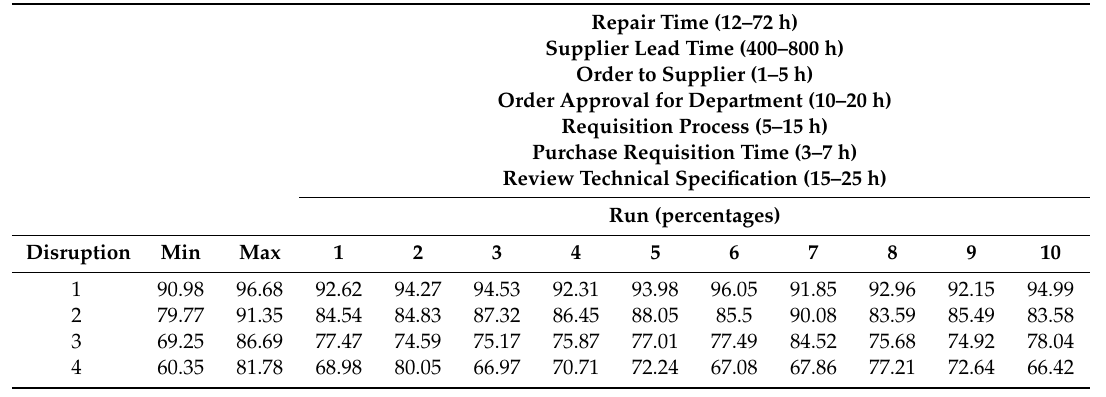
Table 2. Impact of process duration on Complete